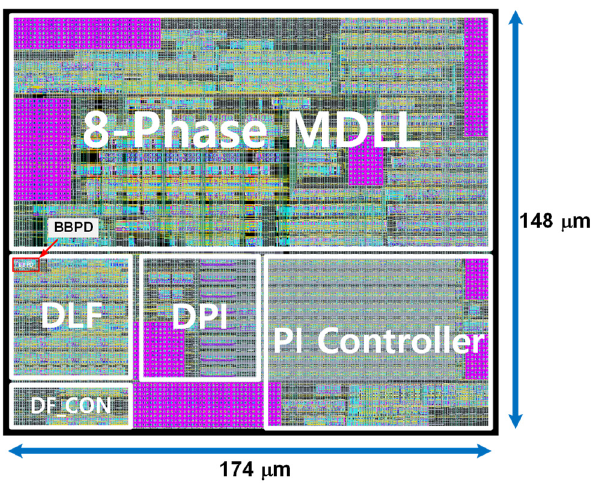
Figure 9. Chip layout of the proposed all-digital DJA.